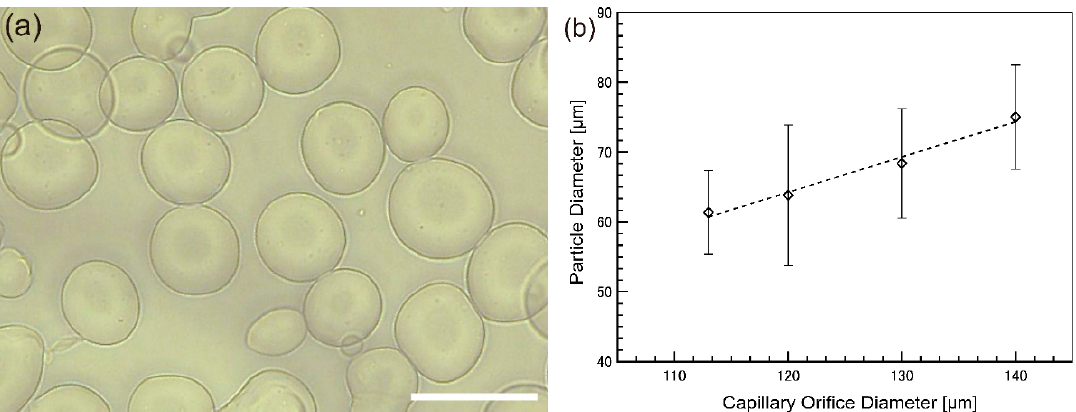
Figure 4. Fabricated particles and size control in a jetting regime: ( a ) A microscopic image of particles obtained through gelation of 2.0% ( w / w ) sodium alginate droplets ejected from a capillary with an orifice of d c = 120 μm in the CaCl 2 solution. The scale bar is 100 μm. The mean particle diameter is 68 ± 10 μm, and n = 100; ( b ) The correlation between d p and d c when droplets of 2.0% ( w / w ) sodium alginate solutions gelate in the CaCl 2 solution.